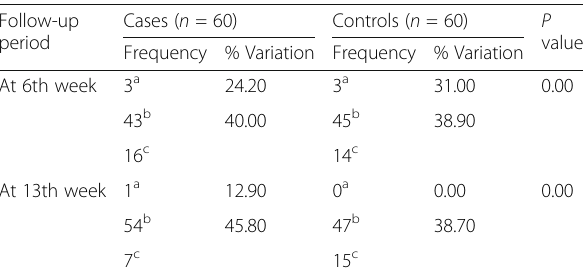
Table 5 Percentage variation in mid-upper arm circumference of participants at the 6th and 13th week